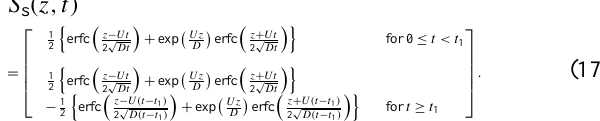
Table 2. Bulk thermal properties of some common soils and their dependence on saturation.